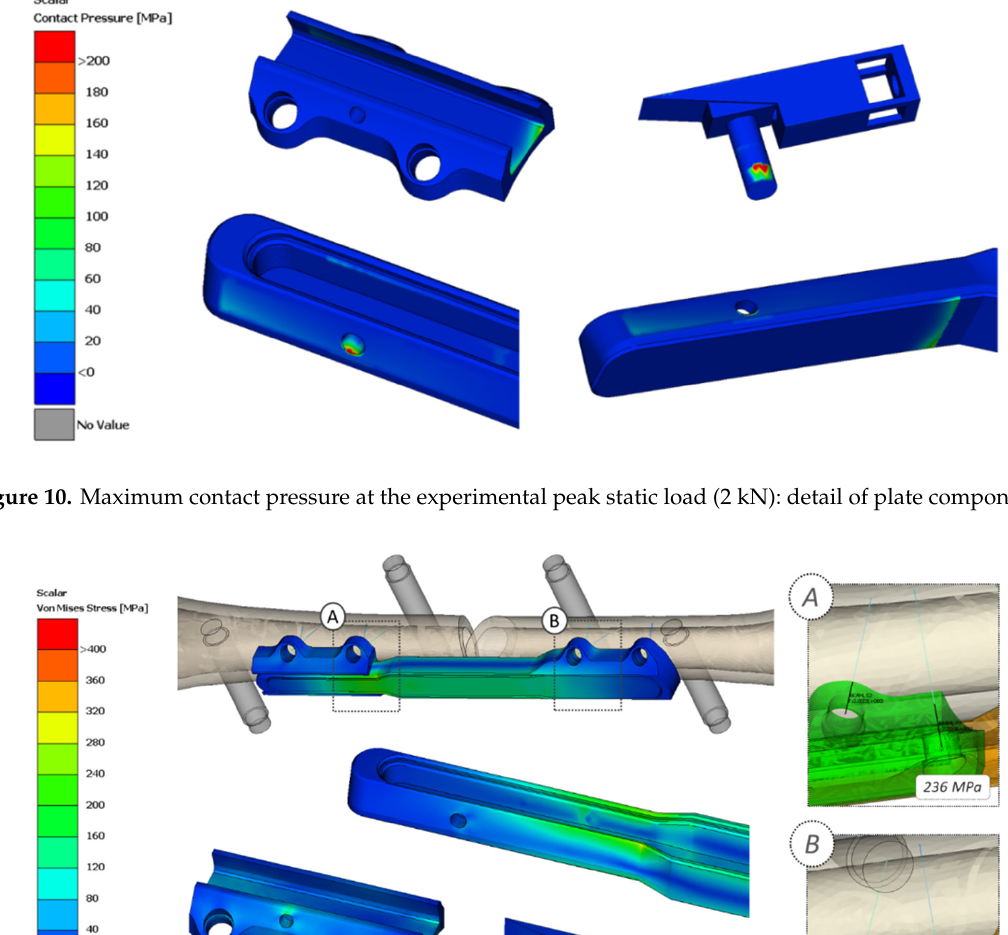
Figure 11. Maximum von Mises stress at 33% of experimental peak static load (660 N): detail of plate components and more stressed screws ( A and B boxes).